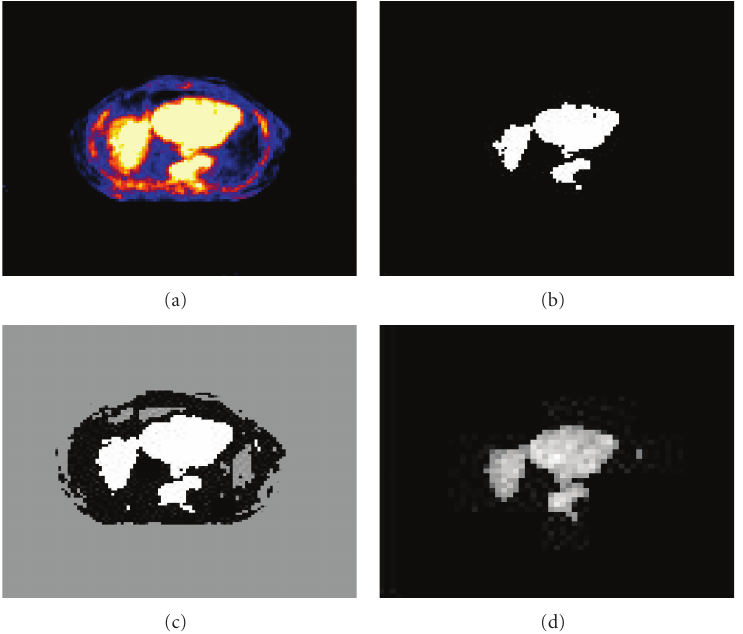
Figure 9: Illustration of algorithm performance on clinical PET data showing: (a) original PET image (128 × 128), (b) thresholded image (128 × 128), (C) clustered image (128 × 128), and (d) segmented image (64 × 64) using ANN and MRA, zoomed by a factor of 2.